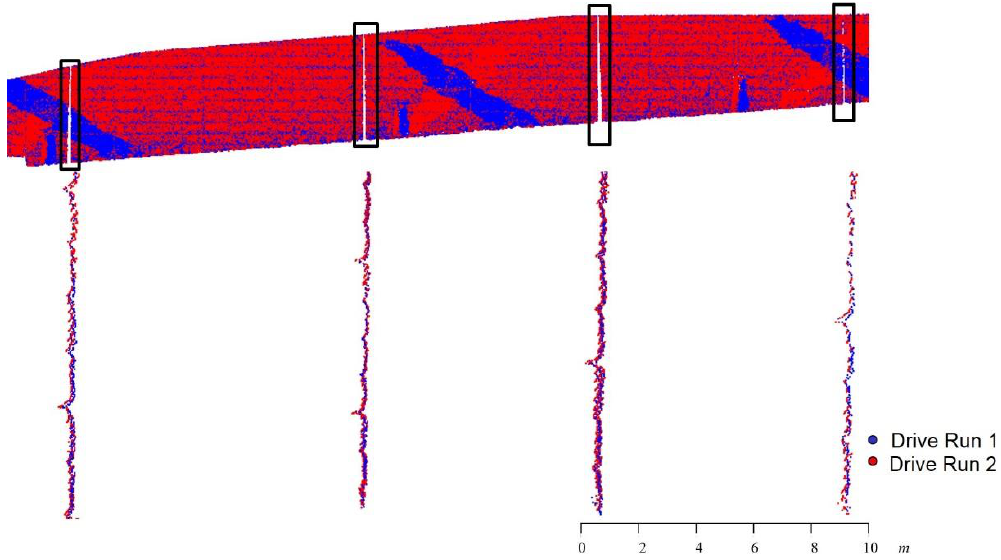
Figure 20. Cross sections illustrating the alignment quality of registered Riegl and ZF scans from a given drive run for the MSE wall at Site-1.